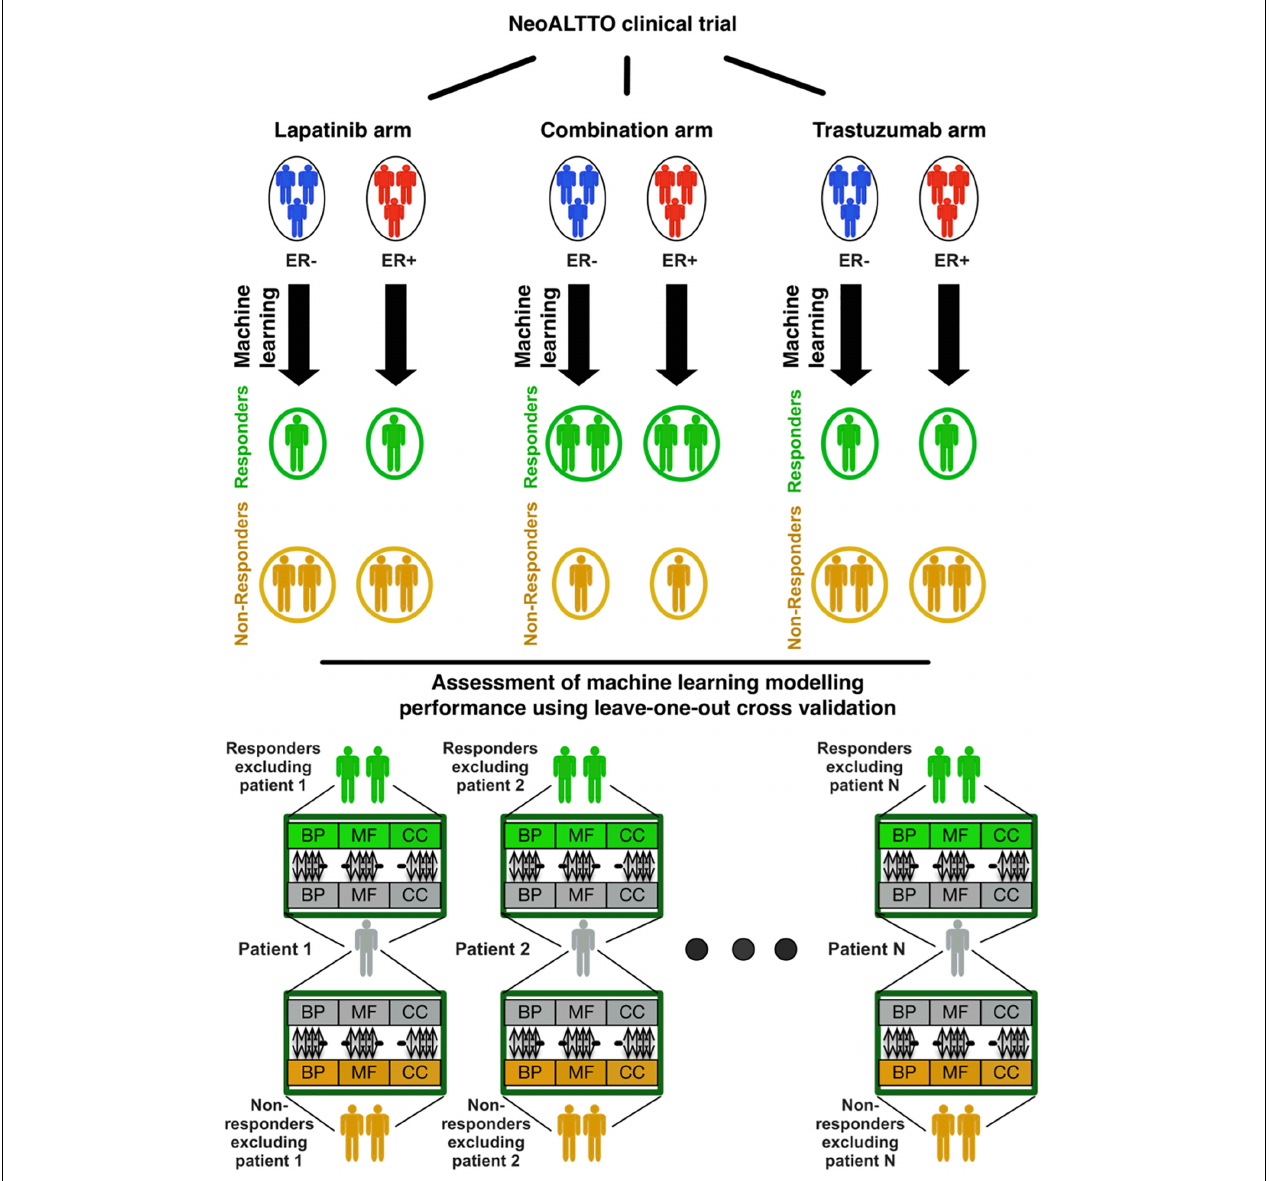
FIGURE 1 | Design of the study regarding identification of responders to lapatinib, trastuzumab, and their combination therapy in the NeoALTTO clinical trial. BP, MF, and CC stand for the Gene Ontology (GO) terms for biological processes, molecular functions, and cellular components,